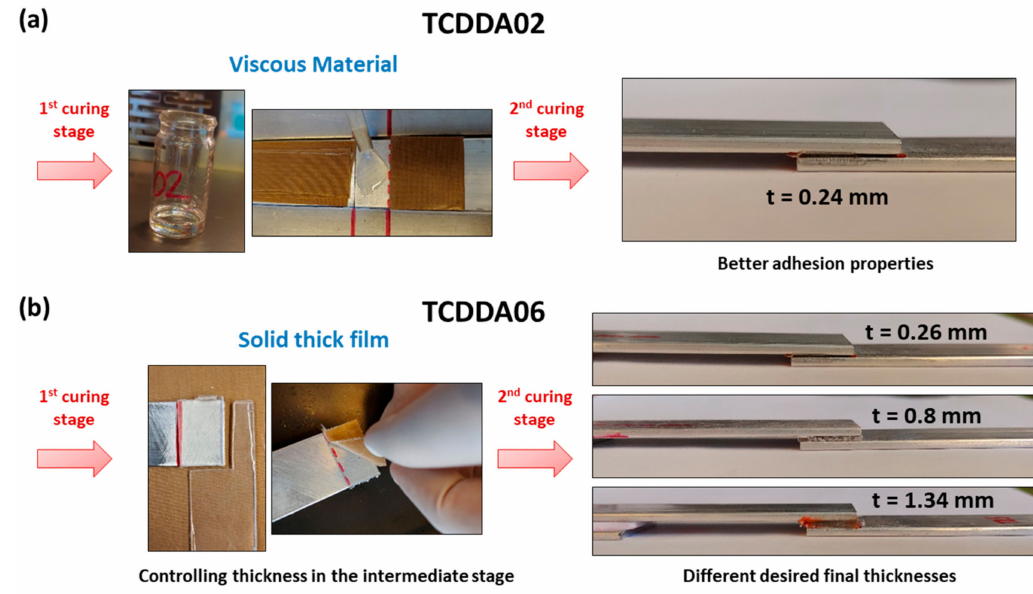
Figure 8. Processing of the adhesive bonding: ( a ) adhesive bonding with the viscous intermediate TCDDA02 material; ( b ) adhesive bonding with the solid intermediate film of TCDDA06.